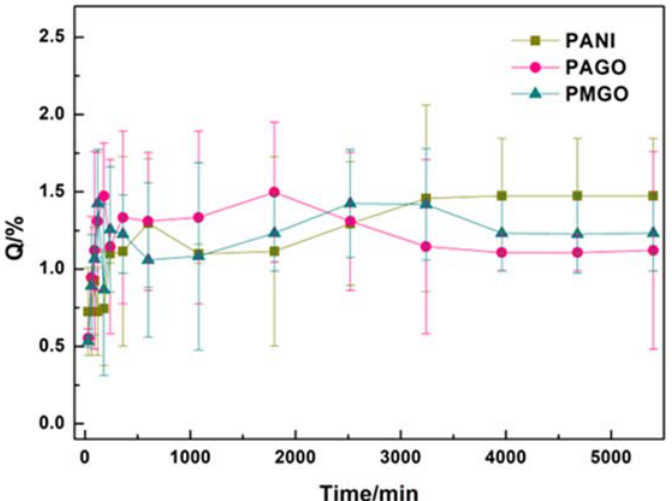
Figure 4. Variation curve of water absorption rate of different coatings .